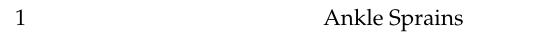
Table A6. PROSPERO. Total articles: